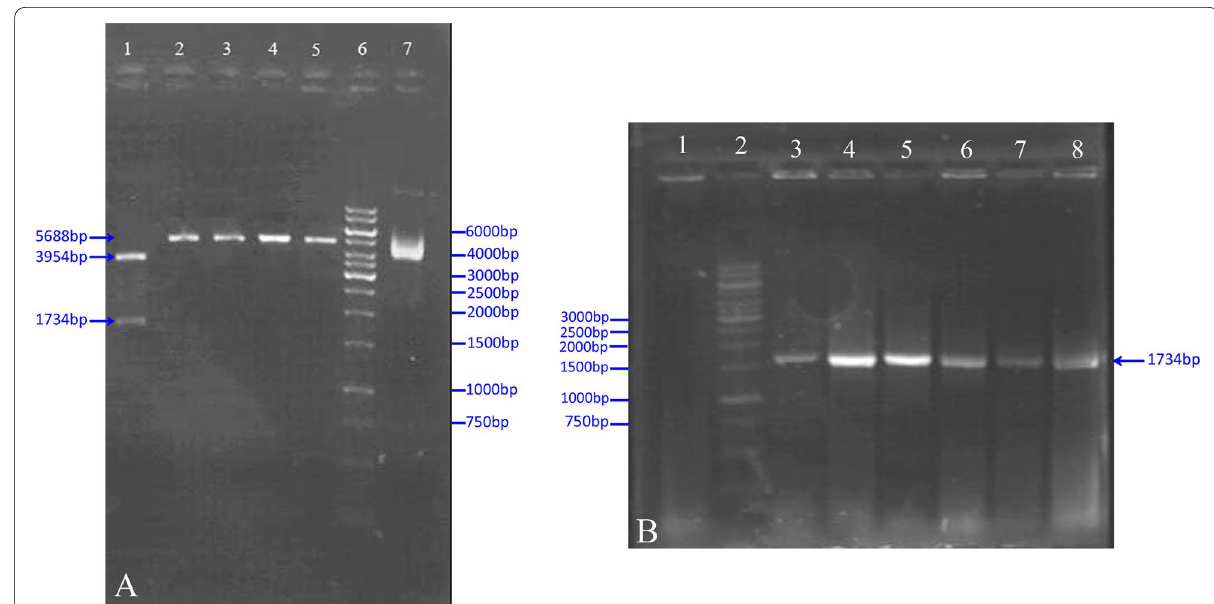
Fig. 2 Enzymatic digestion map of the new pGet-HN recombinant T/A cloning vector. A Lane 1: BamHI/Xb double digestion on the HN-containing recombinant T/A cloning vector (clone) revealed expected 3954-bp and 1734-bp fragments. Lanes 2–5: single digested, revealed expected fragment (5688 bp). Lane 6: 1-kb DNA size marker (Fermentas #SM0311). Lane 7: undigested plasmid of the new HN-containing recombinant T/A cloning vector. B HN, gene PCR with specific primer, six white colonies were selected randomly. Lane 1: negative control (blank). Lane 2: 1-kb DNA size marker (Fermentas #SM0311). Lanes 3–8: HN-gene fragment (1734